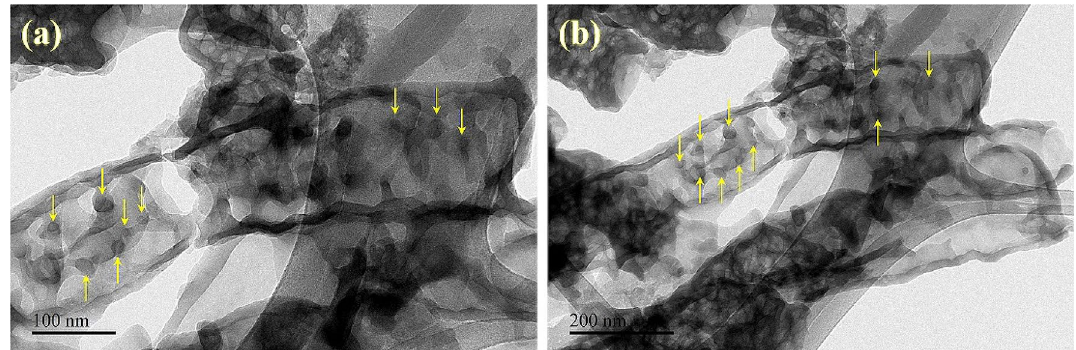
Figure 3. HR-TEM images of 5%Mo-CN sample show Mo nanoparticles’ impregnation on g-C 3 N 4 nanotubes ( a ) HR-TEM micrograph at 100 nm ( b ). HR-TEM micrograph at 200 nm.